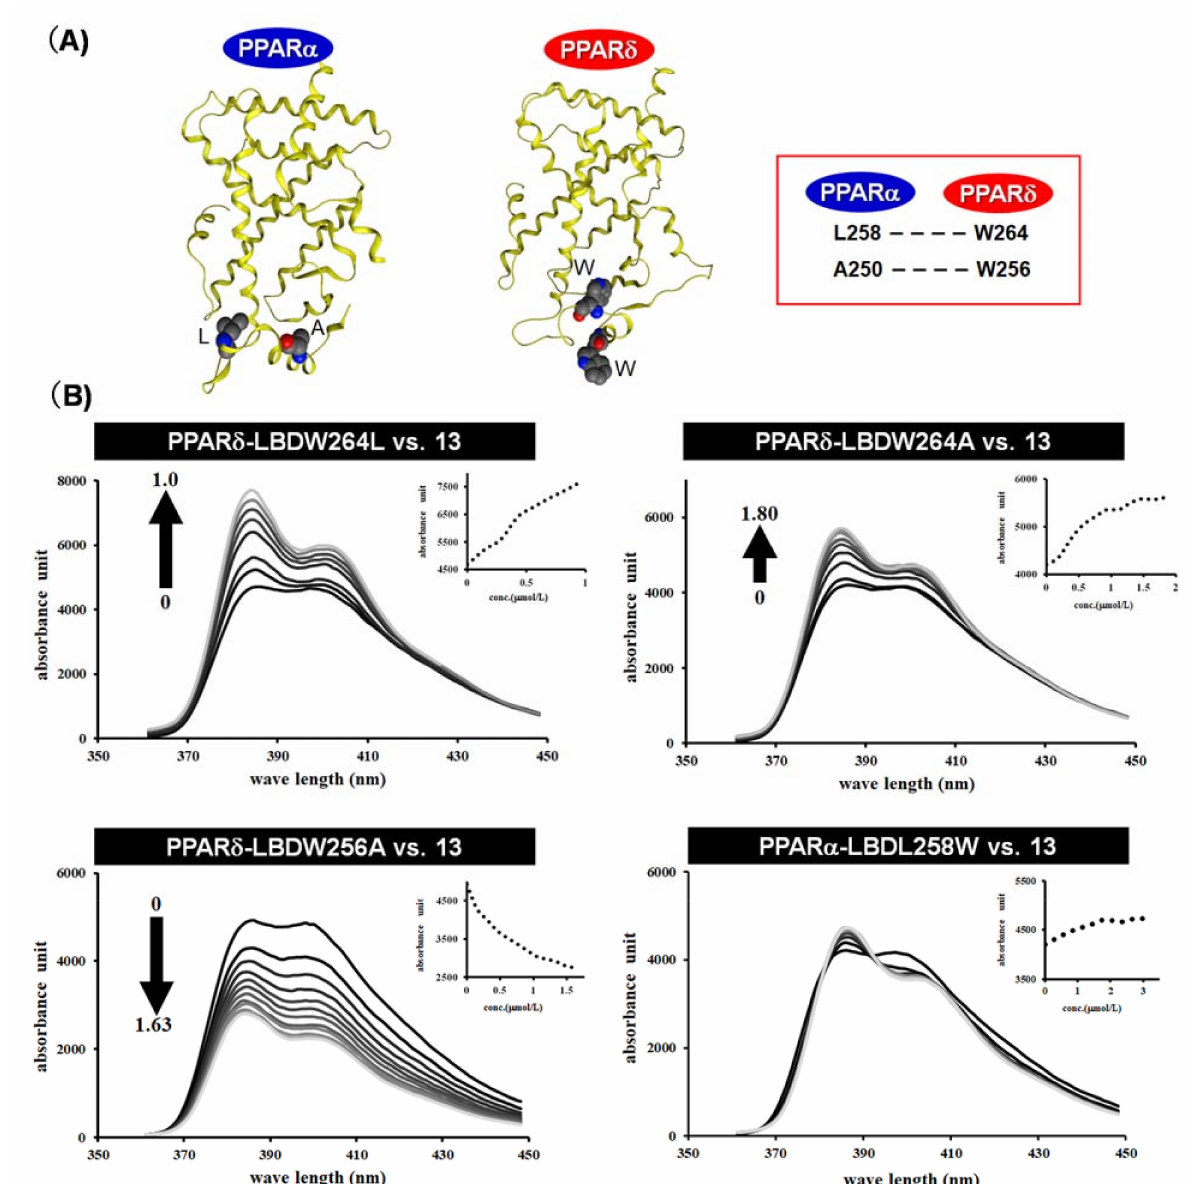
Figure 12. ( A ) X-ray crystallographic structure of the human PPAR α LBD and human PPAR δ LBD. Important amino acids hosting the pyrene moiety are indicated. ( B ) Fluorescence polarization value changes with the addition of mutated human PPAR to APHM-13 in